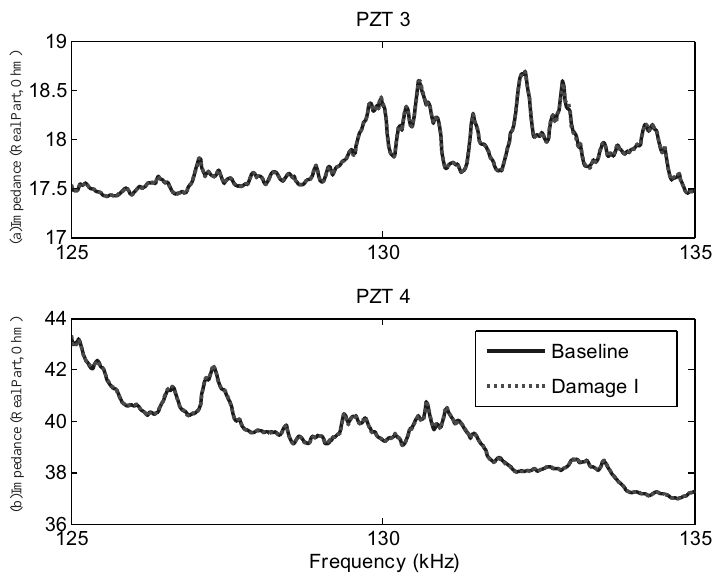
Fig. 4. Electrical Impedance measurement from PZT 3 and PZT 4 before and after Damage